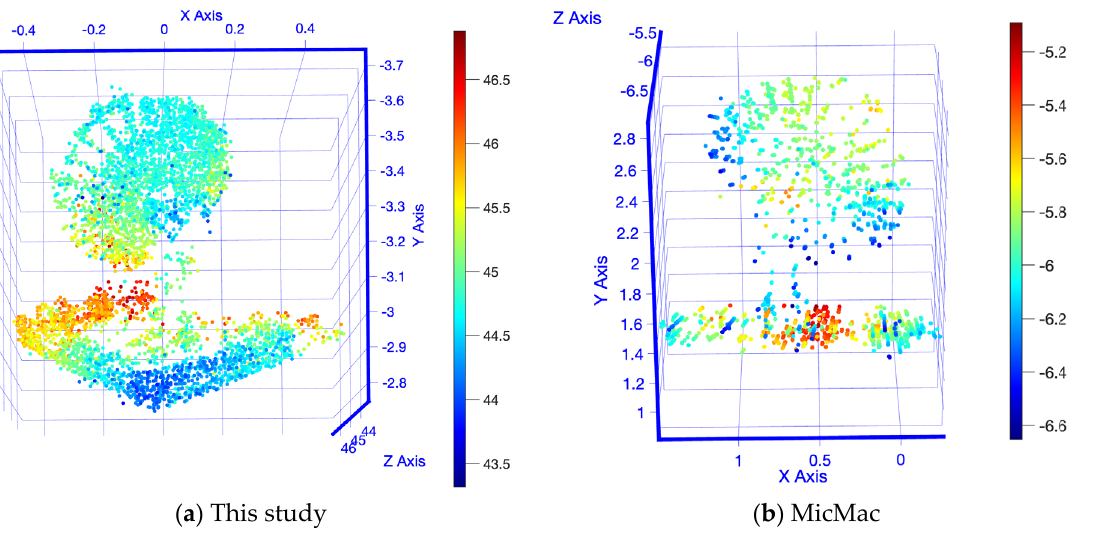
Figure 12. Short baseline 3D reconstruction of the antenna. Table 7. Input and output overview of case 1.